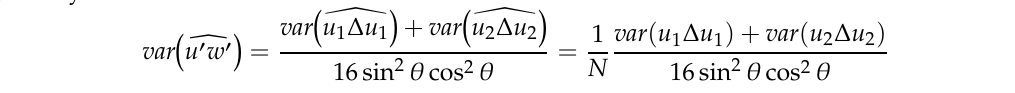
Figure 8. Reynolds stresses ( −𝒖 ′ 𝒘 ′ ) computed by original data (blue dotted line), VAF method (red dotted line), and HA method (black solid line) at ( A ) 9.04 m; at ( B ) 5.04 m; and at ( C ) 1.04 m